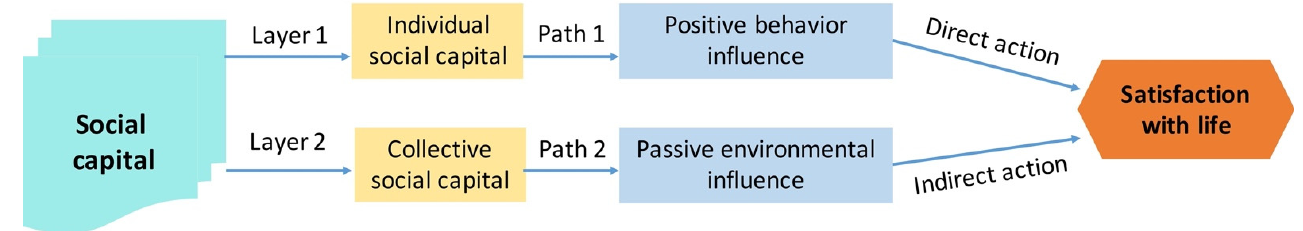
Figure 2. Influence paths of social capital on subjective well-being.